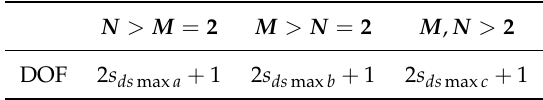
Table 2. The DOFs of the diff–sum coarray for the DsCAMpS